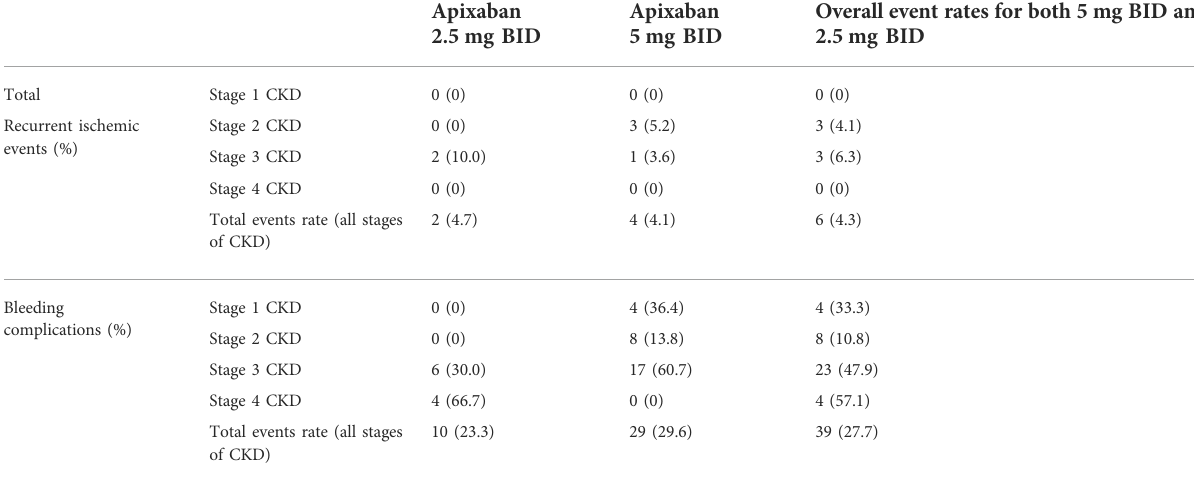
TABLE 3 Clinically Signi fi cant Events in patients receiving apixaban 2.5 mg and 5 mg